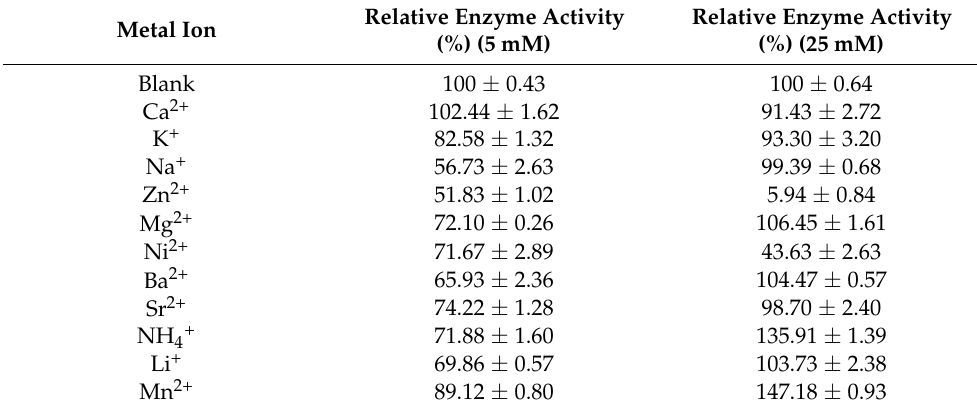
Table 2. Effect of metal ions on protease activity.